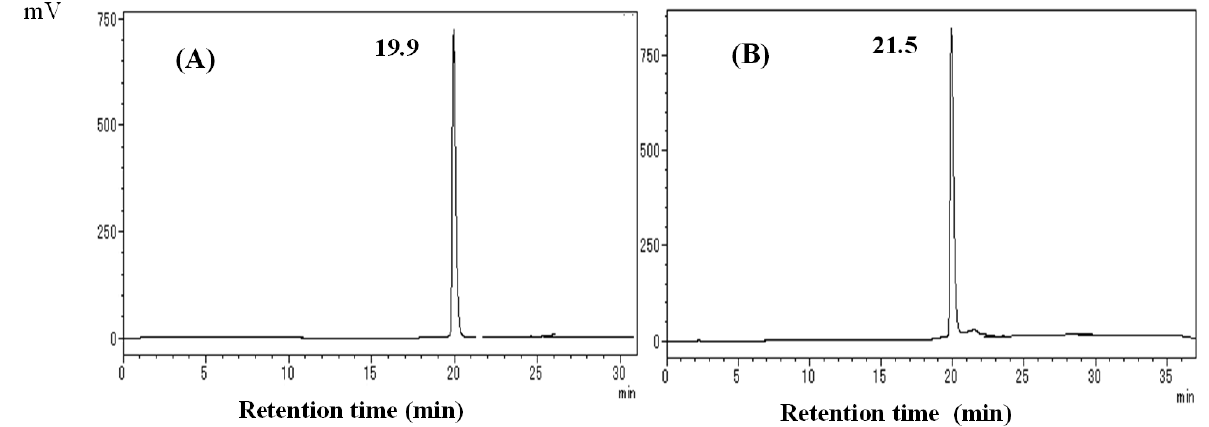
Figure 2. The analytical high performance liquid chromatography (HPLC) chromatograms of A. zerumbet rhizomes ( A ) DK, ( B ) dihydro-5,6-dehydrokawain (DDK). HPLC column: ODS-100Z column (5 µm, 150 × 46 mm i.d.). Flow rate: 0.8 mL/min. Injection volume: 5 µL. Monitored wavelength: 280